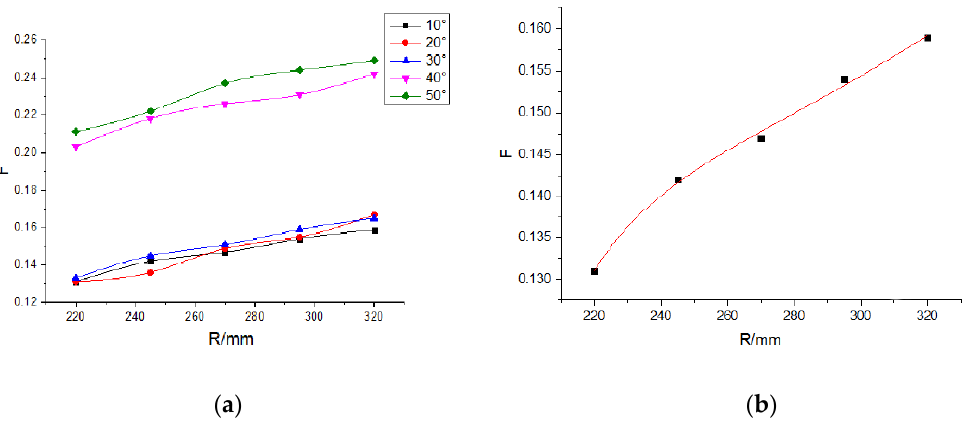
Figure 4. The relationship curve between F and R ( a ) under different crack initiation angles, the law of change of F with R , and the ( b ) fitting curve of F and R when h , L and α are fixed values. It can be observed from Figure 4a,b that the stress intensity factor correction factor F increases with the increase in the curvature radius R of the joint surface between the bot- tleneck of the pressure vessel and the bottle body.